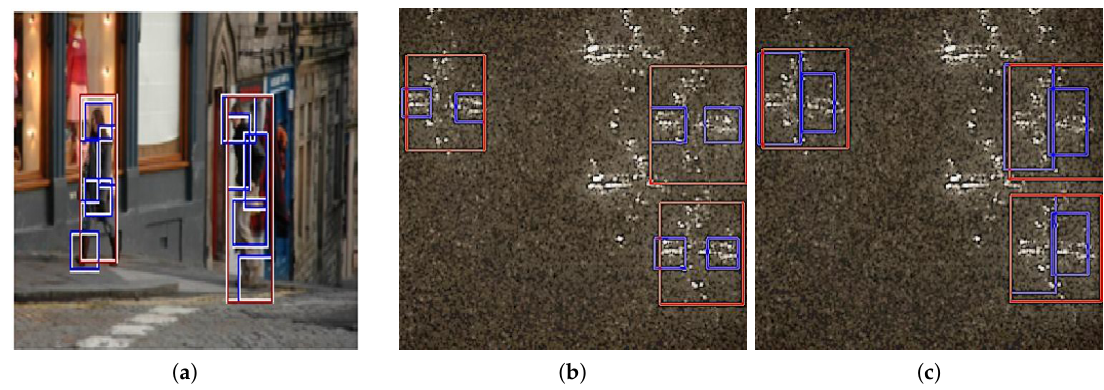
Figure 3. Different detection results. ( a ) Pedestrian detection in the discriminative model; ( b ) Airplane detection in the discriminative model; ( c ) Airplane detection in the Adaptive Component Selection-Based Discriminative Model (ACSDM)